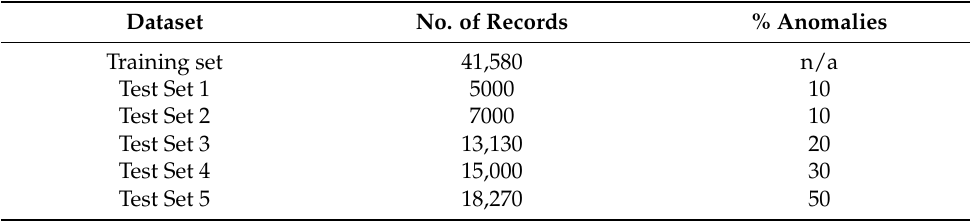
Table 1. Number of records and proportion of anomalies in training and test data sets.